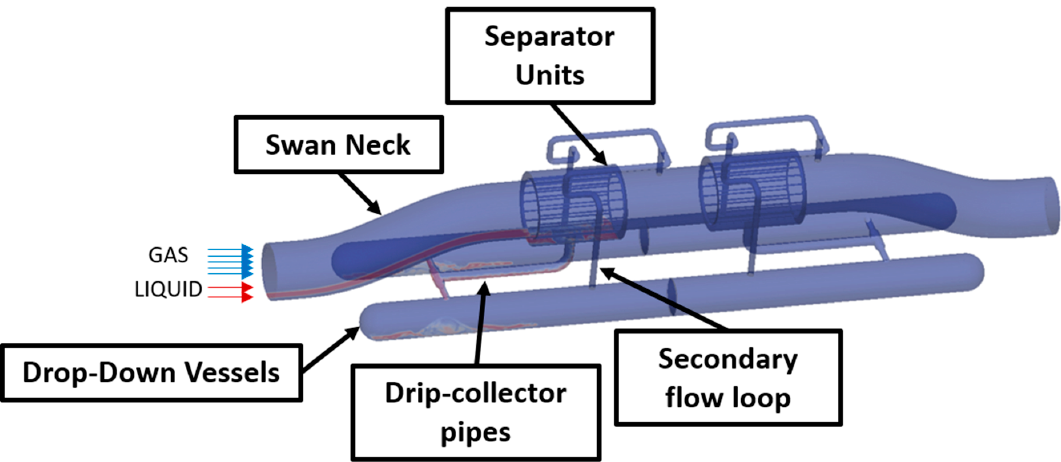
Figure 1. Schematic of a typical separator that we consider in this study. A stratified fluid mixture enters the main pipeline, to find an inclined surface, referred to as the swan neck. At the top of the swan neck there are two separator units. Any water that enters these units should be removed through the drip-collector pipes and into the drop-down vessels. To regulate the pressure in the drop-down vessels, a secondary flow loop allows gas coming into the drop-down vessels to circulate back into the main pipeline.